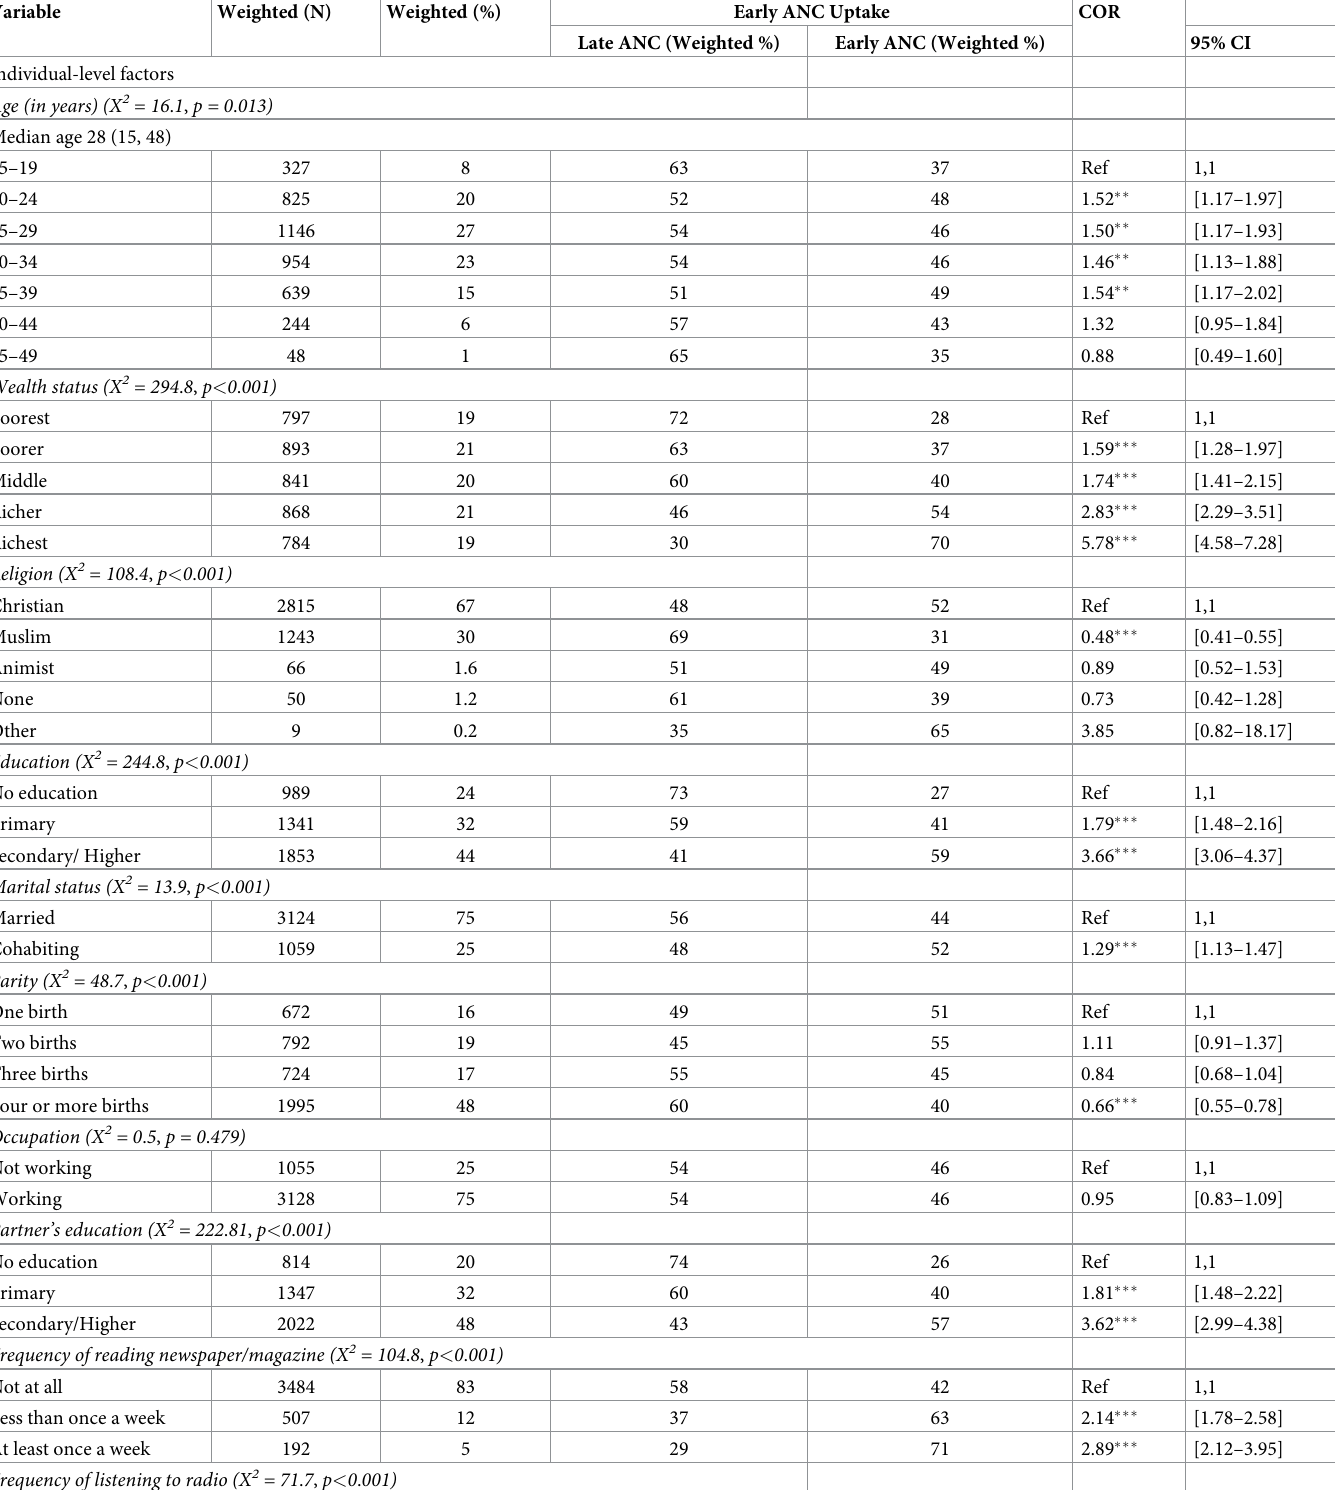
Table 1. Individual and community-level factors and uptake of early ANC (Weighted N =